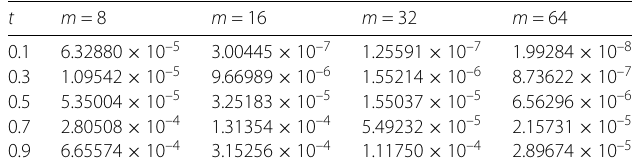
Table 5 Absolute error for ρ = 1.45, α 1 = 1.55, α 2 = 0.75, and for different fixed values of